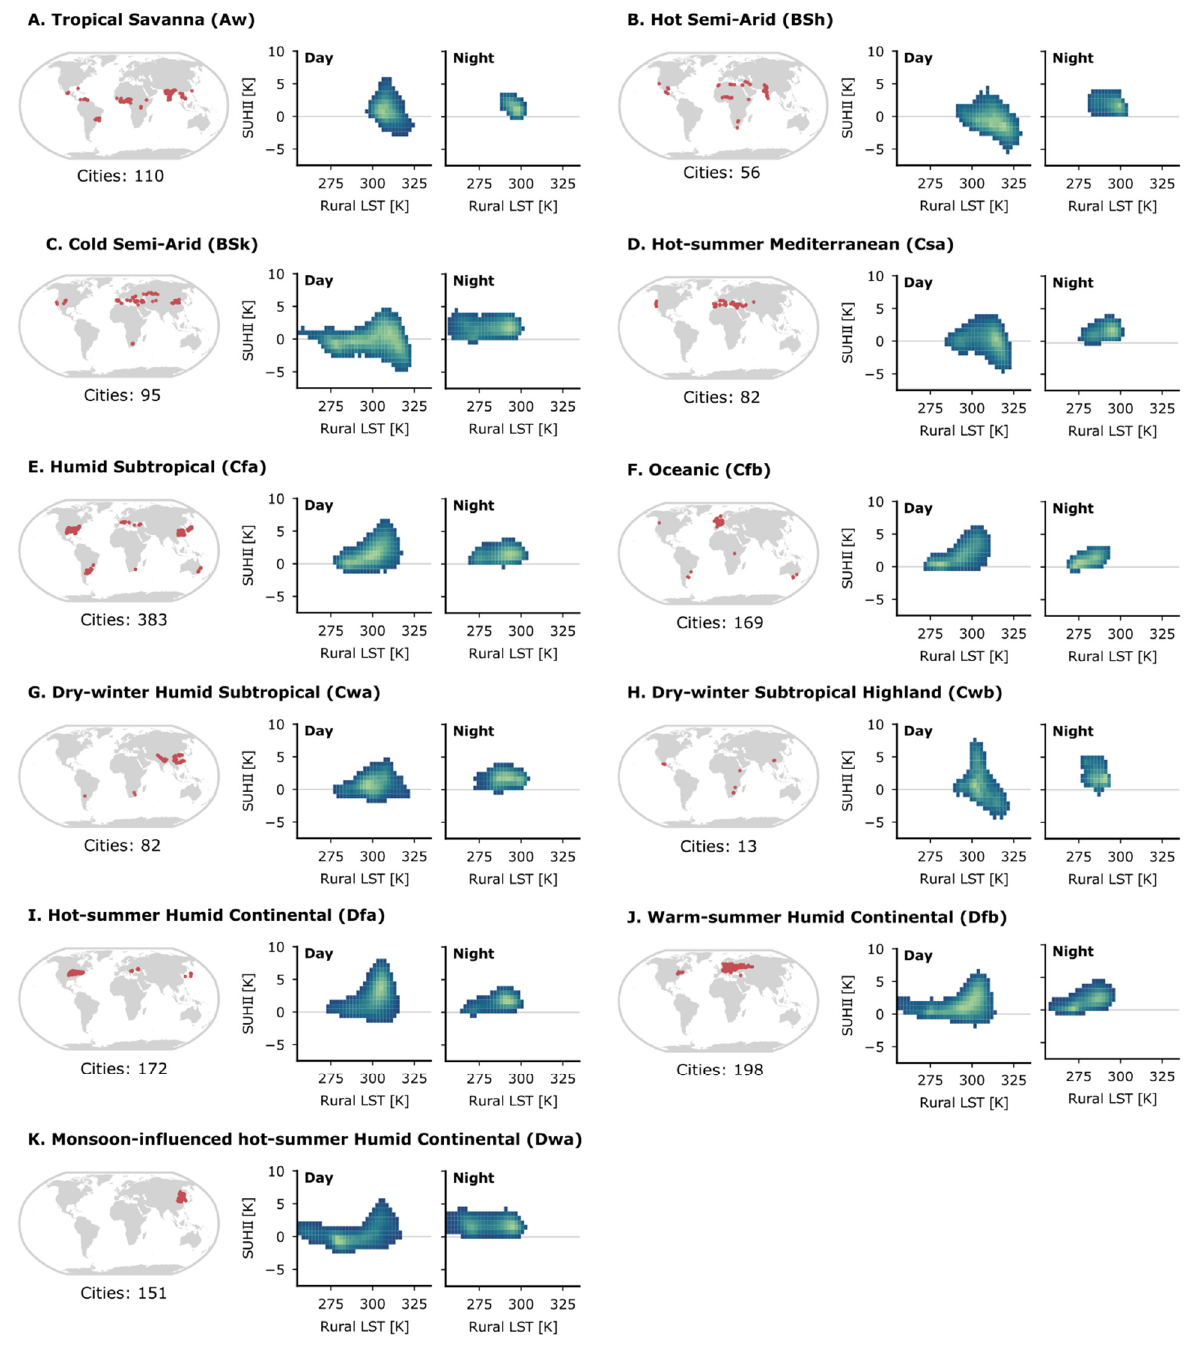
Figure 2. The location and number of delineated cities per Köppen–Geiger climate class and the corresponding daytime and nighttime SUHII climatologies visualized as the bivariate distribution of daily SUHII and rural LST. Each distribution presents all the possible combinations of SUHII and rural LST and is unique and characteristic of the respective climate class. The colors indicate how likely each combination is: yellow indicates the most likely and blue the least.